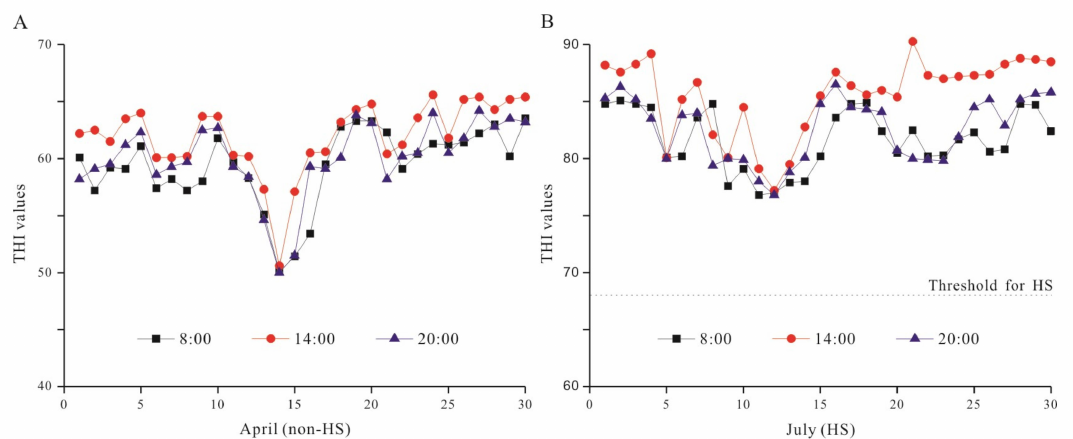
Figure 1. Temperature–humidity index (THI) values of the dairy barn in April and July. ( A ) Daily changes in THI values in the non-heat stress (HS) season (April); ( B ) Daily changes in THI values in the HS season (July). THI was recorded in the morning (08:00), afternoon (14:00), and night (20:00) each day. All the THI values were higher than the HS threshold of 68 in